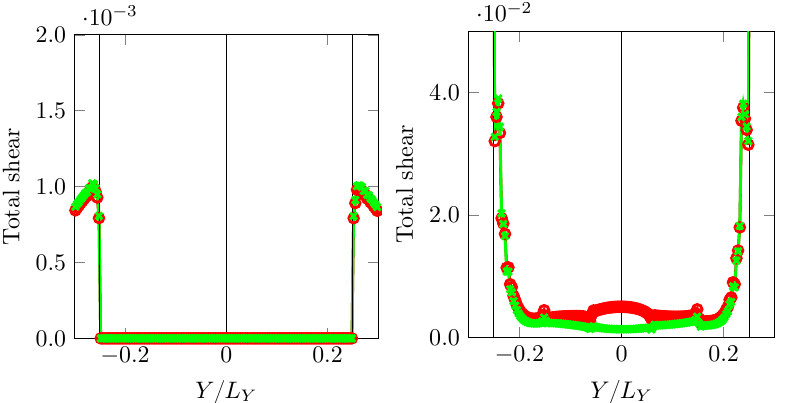
( a ) Distribution of σ 11 . Red and green curves represent results for hard and soft martensite variants between O 1 O 2 , respectively.